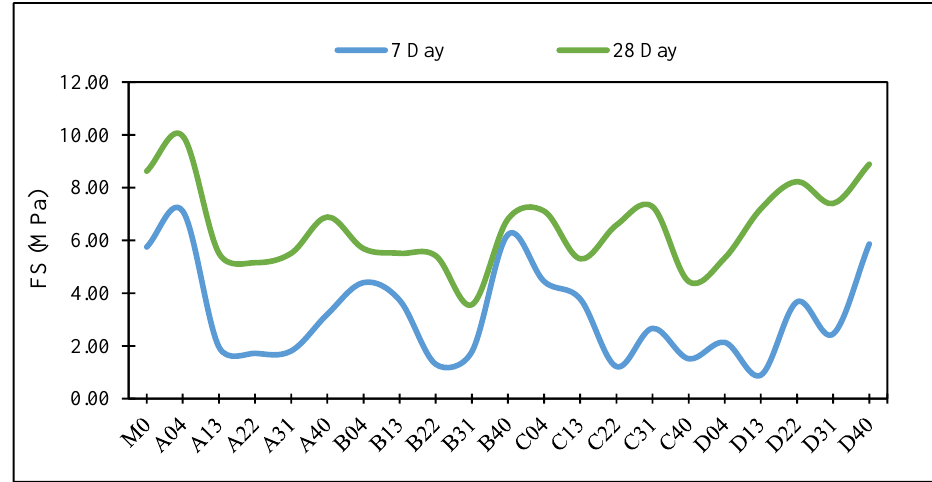
Figure 4. FS Results Based on Experimental Studies.